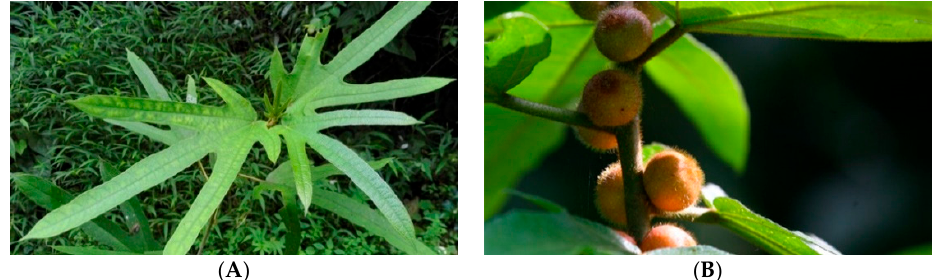
Figure 1. The ( A ) leaves and ( B ) fruits of hairy fig ( Ficus hirta Vahl.).